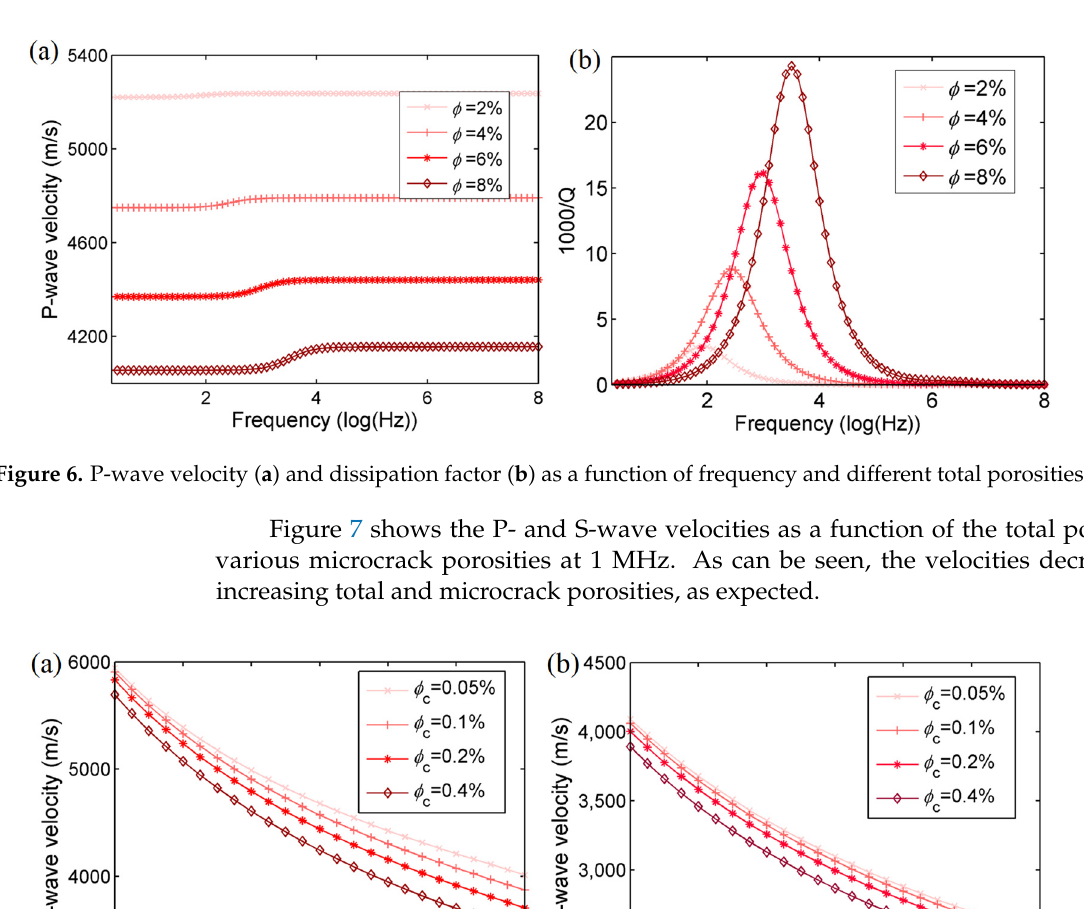
Figure 8. P- and S-wave velocities ( a ) and their ratio ( b ) as a function of effective pressure. Figure 8b shows the velocity ratio. In the full gas saturation case,